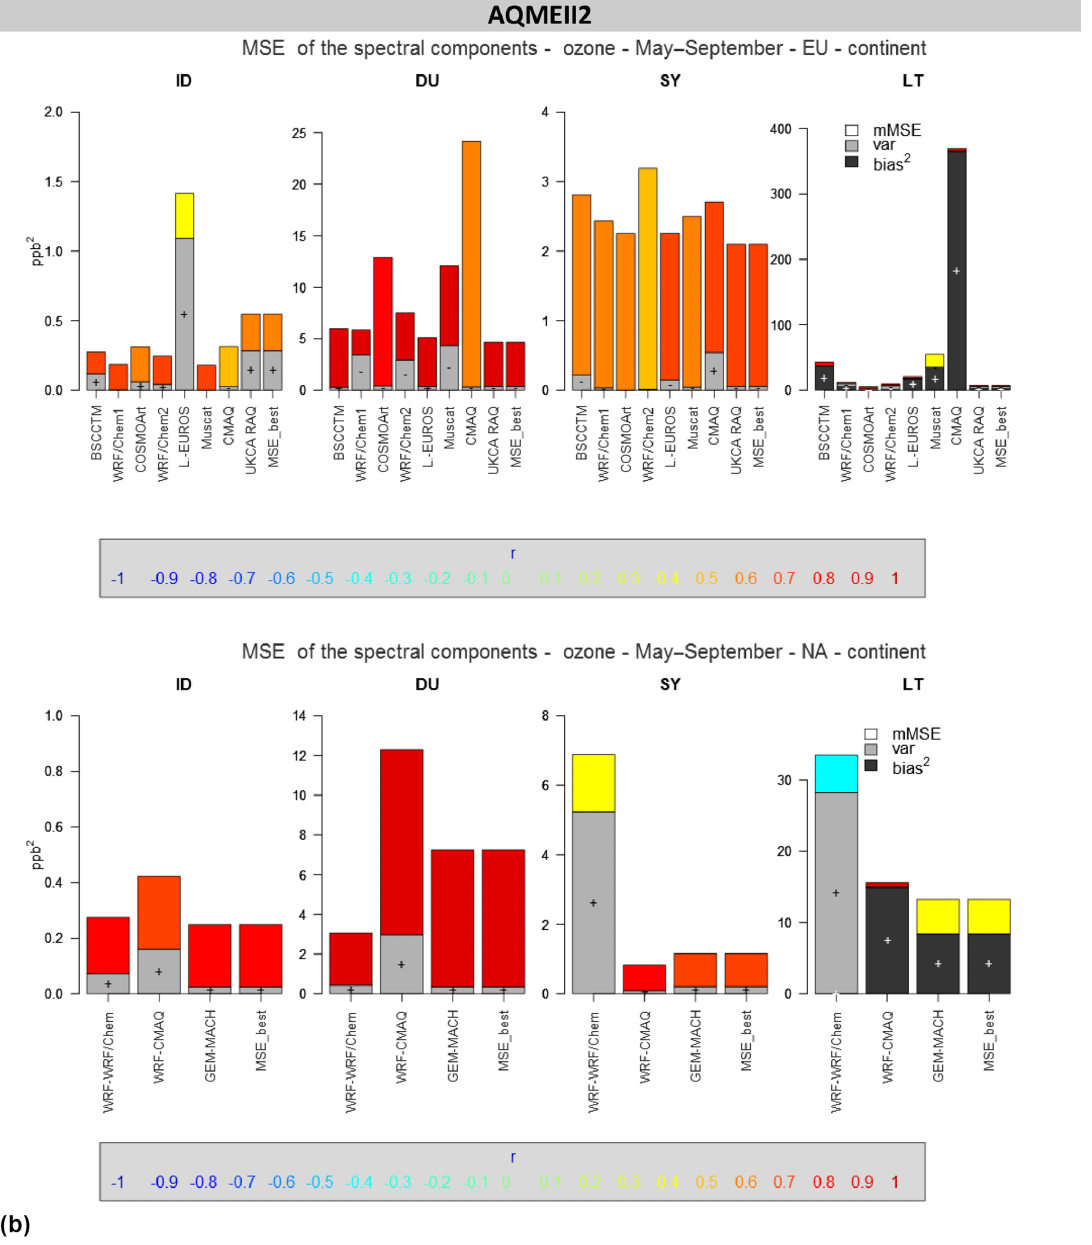
Figure 2. MSE (ppb 2 ) breakdown in bias squared, variance and mMSE of the spectral components ID, DU, SY, LT, based on Eq. (9). The bias is entirely accounted for by the LT component. The sign within the share of bias and variance indicates model overestimation ( + ) or underestimation ( − ) of mean concentration (bias) and variance. The colour of the mMSE share of the error is coded based on the values of r , the correlation coefficient, according to the colour scale at the bottom of each plot. (a) AQMEII1 and (b) AQMEII2. Top panel: EU; lower panel: